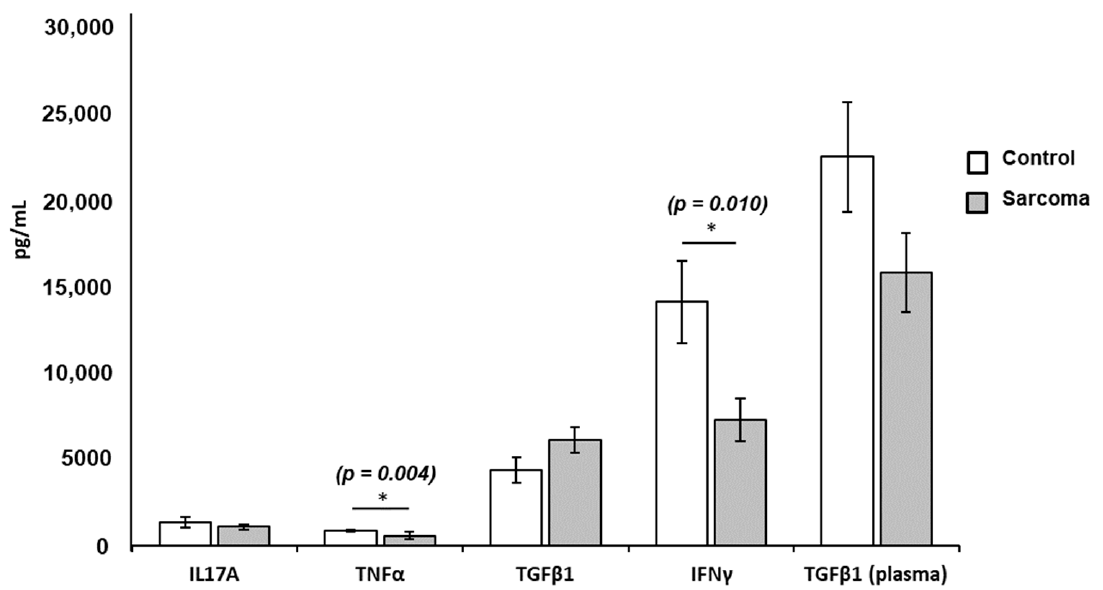
Figure 3. Mean concentrations of TNF- α , IFN- γ , IL-17A, and TGF- β 1 in the PBL-stimulated culture supernatant and plasma levels of TGF- β 1 from sarcoma patients and normal controls. Results show significantly lower levels of TNF- α (* p = 0.004; 562.87 ± 190.69 pg/mL) and IFN- γ (* p = 0.010; 7218.27 ± 1216.02 pg/mL) in sarcoma patients compared to normal controls (TNF- α = 843.74 ± 85.95 pg/mL; IFN- γ = 14,041.66 ± 2379.13 pg/mL). Each data point is rep- resented as mean concentration of cytokines ± standard error (SE). The levels of IL-17A, TGF- β 1, and plasma TGF- β 1 did not show significance in sarcoma patients when compared to normal